Question: Is the quantity shown trending increasing or decreasing?
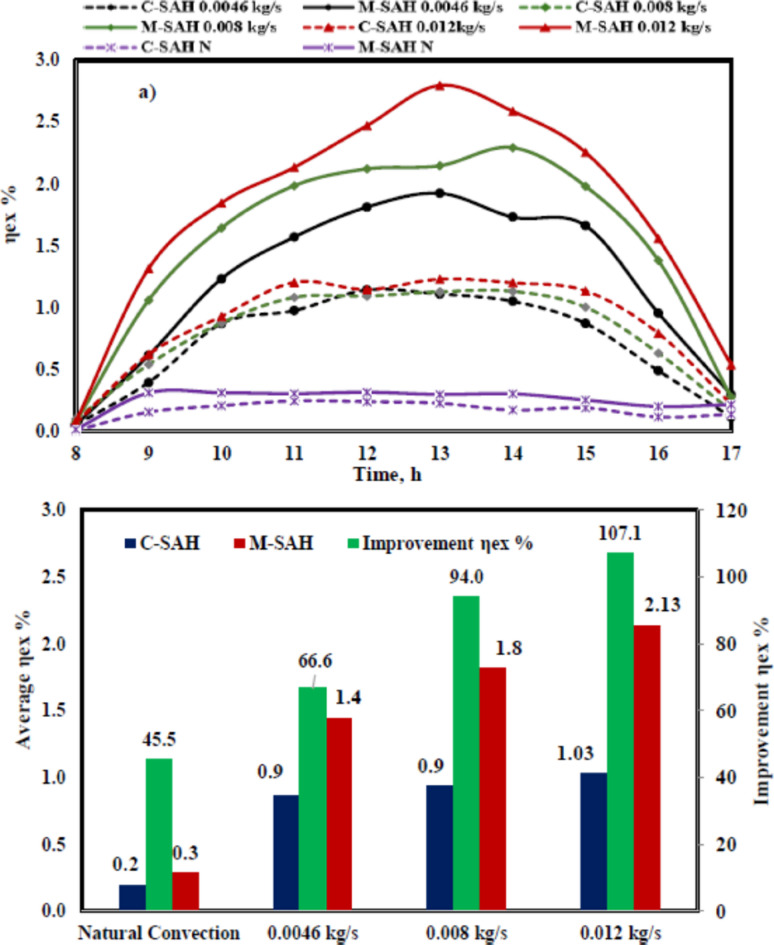
Answer: increasing